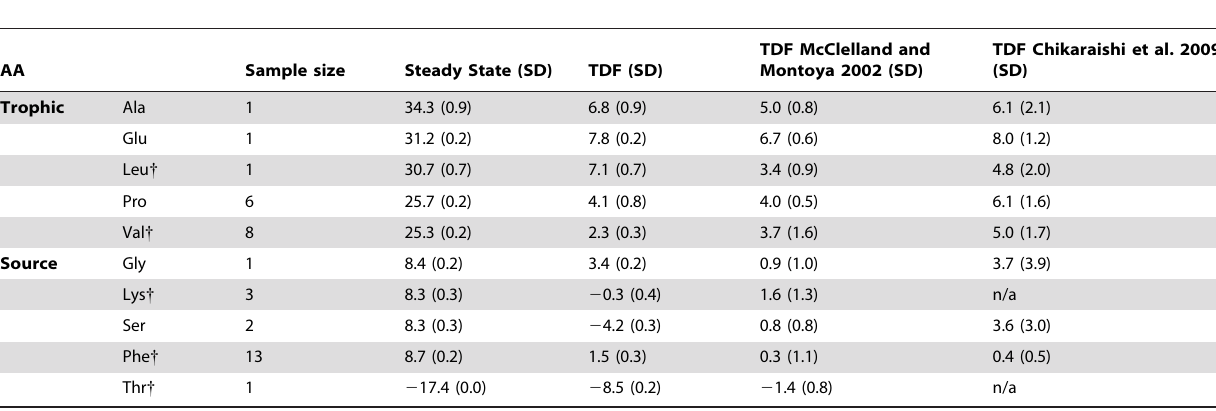
Table 6. Data-derived steady-state nitrogen isotopic composition and TDF values of individual amino acids in Pacific bluefin tuna ( Thunnus orientalis ).